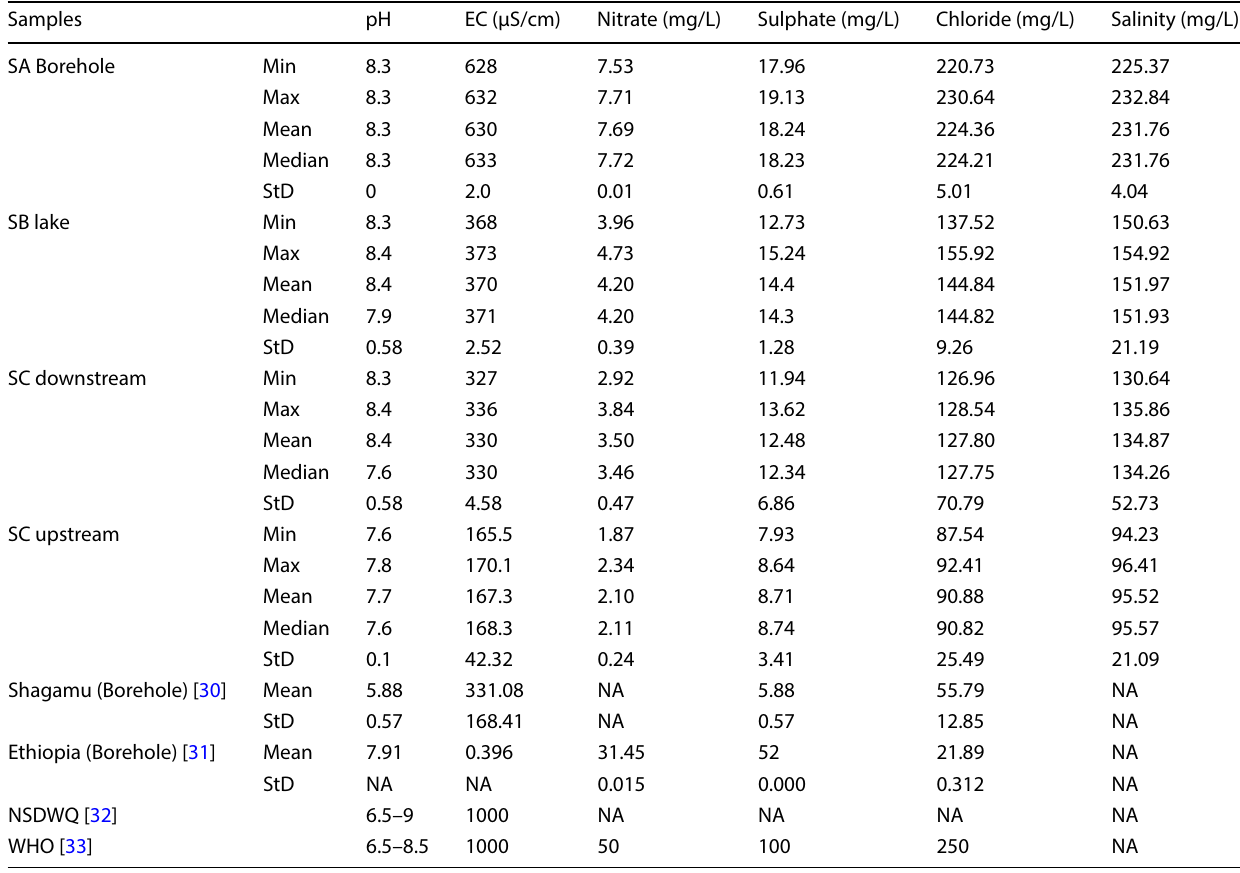
Table 4 Physicochemical properties of the tested waters